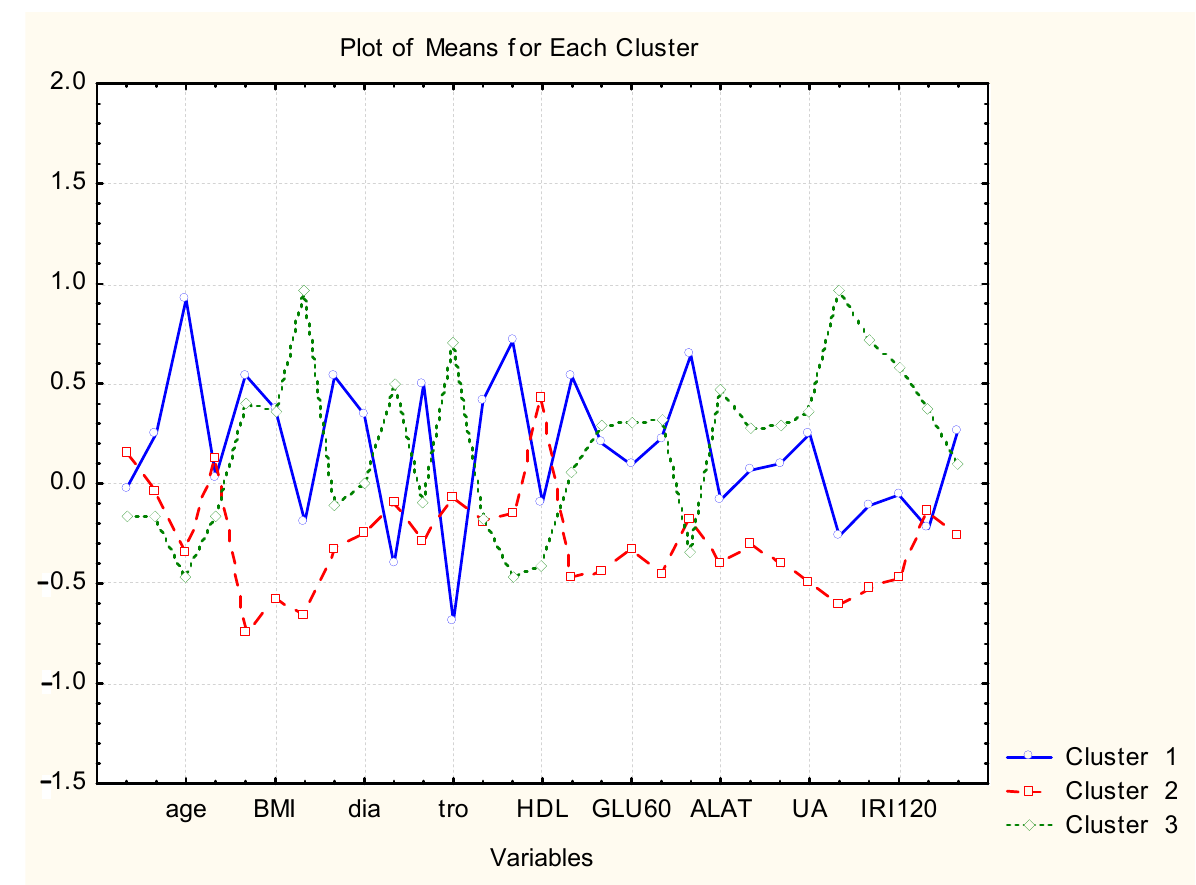
Figure 3. Plot of means of each descriptor (variable) for each identified cluster. The included variables (some of the variables are omitted for clarity) order in the axis as follows are presented with their abbreviations are metanephrine (MN), normetanephrine (NMN), age, height, waist, body mass index (BMI), HOMA-IR, systolic blood pressure (sys), diastolic blood pressure (dia), leucocytes (leu), hemoglobin (hb), thrombocytes (tro), mean corpuscular volume (mcv), total cholesterol (chol), HDL-cholesterol (HDL), triglycerides (tg), fasting glucose (GLU0), glucose at the first hour post glucose load (GLU60), glucose at the second hour post glucose load (GLU120), creatinine (kreatinin), alanine aminotransferase (ALAT), aspartate aminotransferase (ASAT), gamma-glutamyl transferase (GGT), uric acid (UA), fasting insulin (IRI0), insulin at the first hour post glucose load (IRI60), insulin at the second hour post glucose load (IRI120), free urine cortisol (UFC), and thyroid stimulating hormone (TSH).